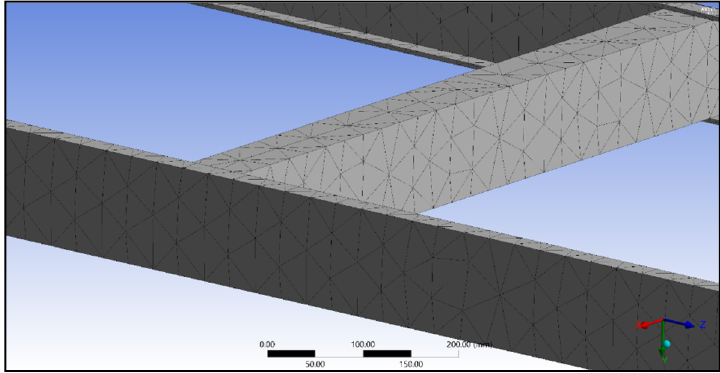
Figure 3. Enlarged view of meshed model showing tetrahedral elements.